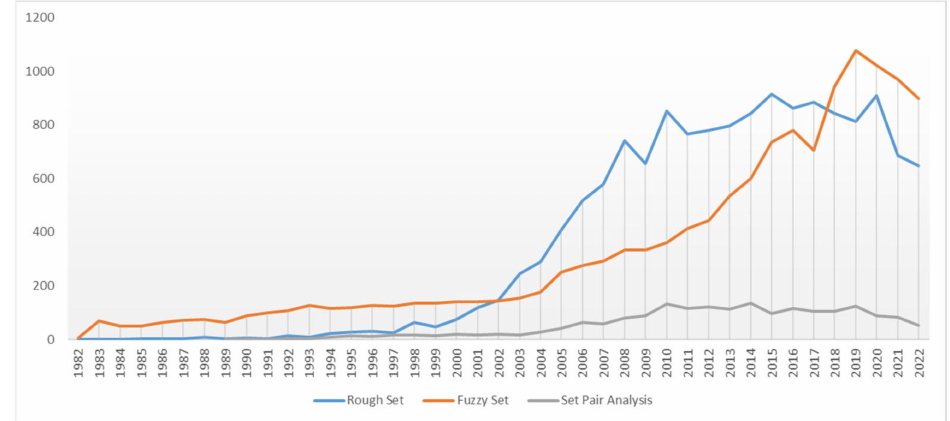
Figure 2. The changing trend of literature related to set pair analysis, rough set and fuzzy set